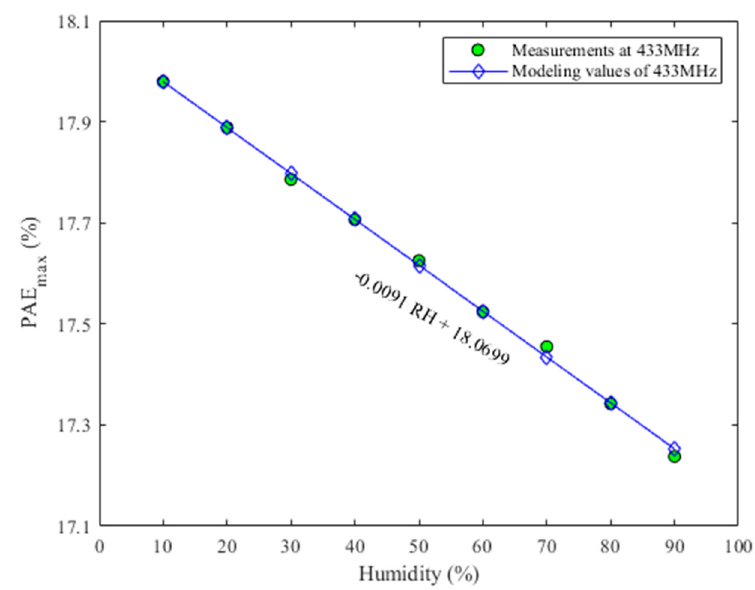
Figure 9. Measured maximum PAE vs. humidity at 433 MHz.